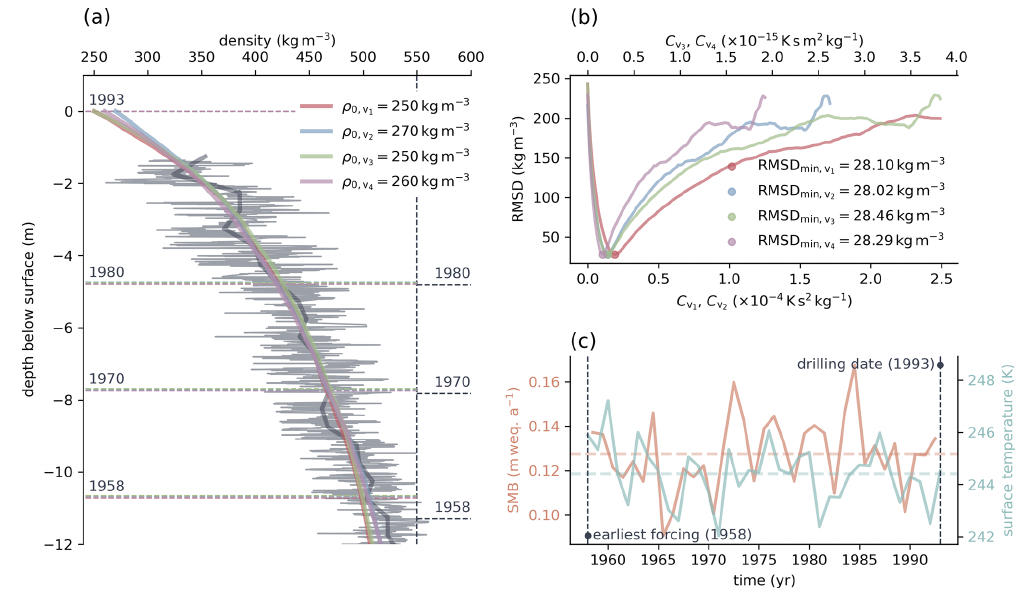
Figure 1. (a) Depth density profile of ice core ngt03C93.2 (Wilhelms, 2000) retrieved in Greenland (gray) and best corresponding model results obtained using four variants of constitutive law for grain boundary sliding of Alley (1987) (various colors). Dark gray line shows the mean density of the ice core calculated using a window of 0.5m starting at the surface. Dashed horizontal lines represent horizons of firn deposited in the indicated years, where 1958 is the first year that forcing from RACMO2.3 (Van Wessem et al., 2014; Noël et al., 2015) is available. Colored dashed horizontal lines show horizons obtained in the simulations. Horizons plotted in gray (to the right of the vertical dashed line) represent the same surfaces as those determined by Miller and Schwager (2004) during analysis of the core. (b) RMSD between measured and modeled density plotted over the range of tested factor values. Note the different axes for different tested factors. (c) Representative forcing at the location of ice core ngt03C93.2, which was used in the simulation. Horizontal dashed lines show the mean values of the surface mass balance and surface temperature during the